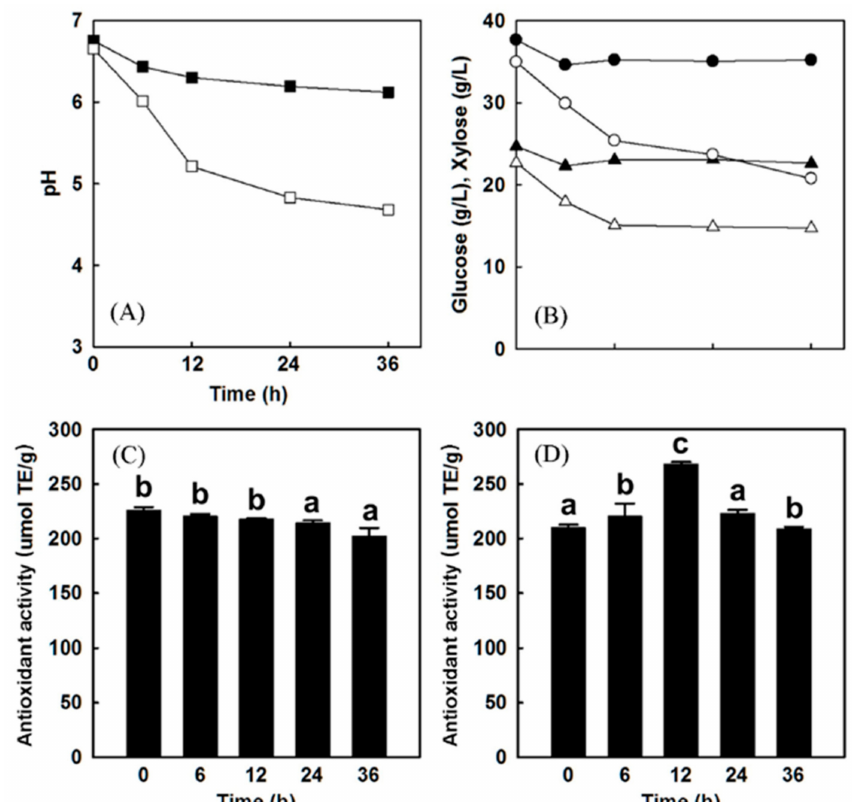
Figure 6. Results after L. plantarum LP-115 fermentation of the mixed berry juice (73% acai, 17% aronia, 10% cranberry) ( A ) Change in pH over time with (open square) and without (closed square) L. plantarum LP-115 inoculation. ( B ) Amount of glucose (circles) and xylose (triangles) consumptions over time with (open symbols) or without (closed symbols) addition of L. plantarum LP-115. ( C ) Change in antioxidant activities over time without inoculation of L. plantarum LP-115. ( D ) Changes in antioxidant activities over time with inoculation of L. plantarum LP-115. Error bars indicate standard deviation. Values with the same letter are not statistically significant based on Sche ff e’s multiple range test [83]. Provided by the Springer Nature SharedIt content-sharing initiative https: // rdcu.be /